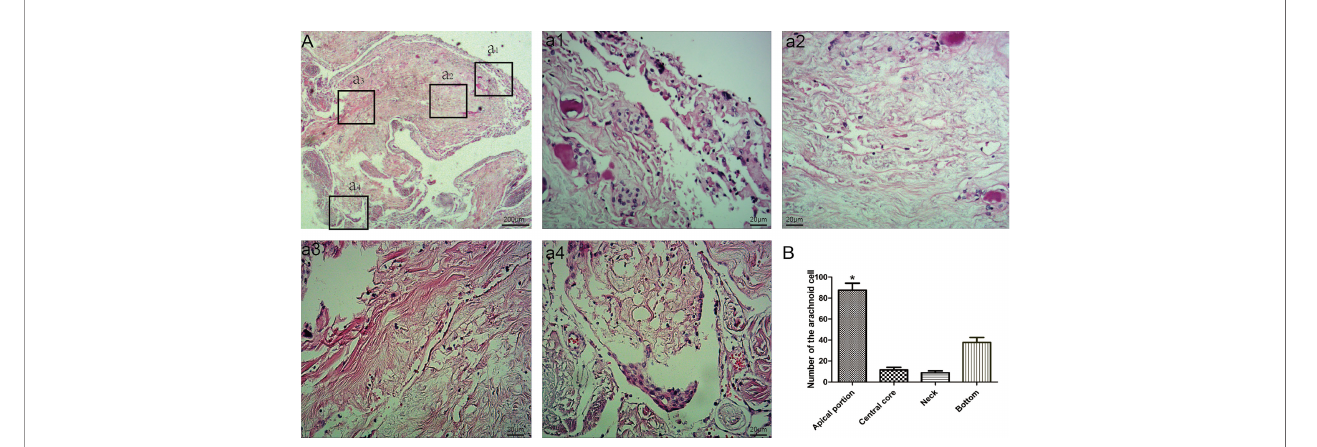
FIGURE 2 | Morphological characteristics of arachnoid granulations. Endothelial cells and arachnoid cells present in the cap cell section ( a1 ; HE staining, ×200); Loose connective tissue can be seen in the central core, with a net-like structure ( a2 ; HE staining, ×200); Dense connective tissue at the base ( a3 ; HE staining, ×200); A large number of vacuole-like tissues present in the neck ( a4 ; HE stain, ×200); Comparison of the number of arachnoid cells in different parts; *: means compared with central core, neck and bottom, (P < 0.05) (B) .